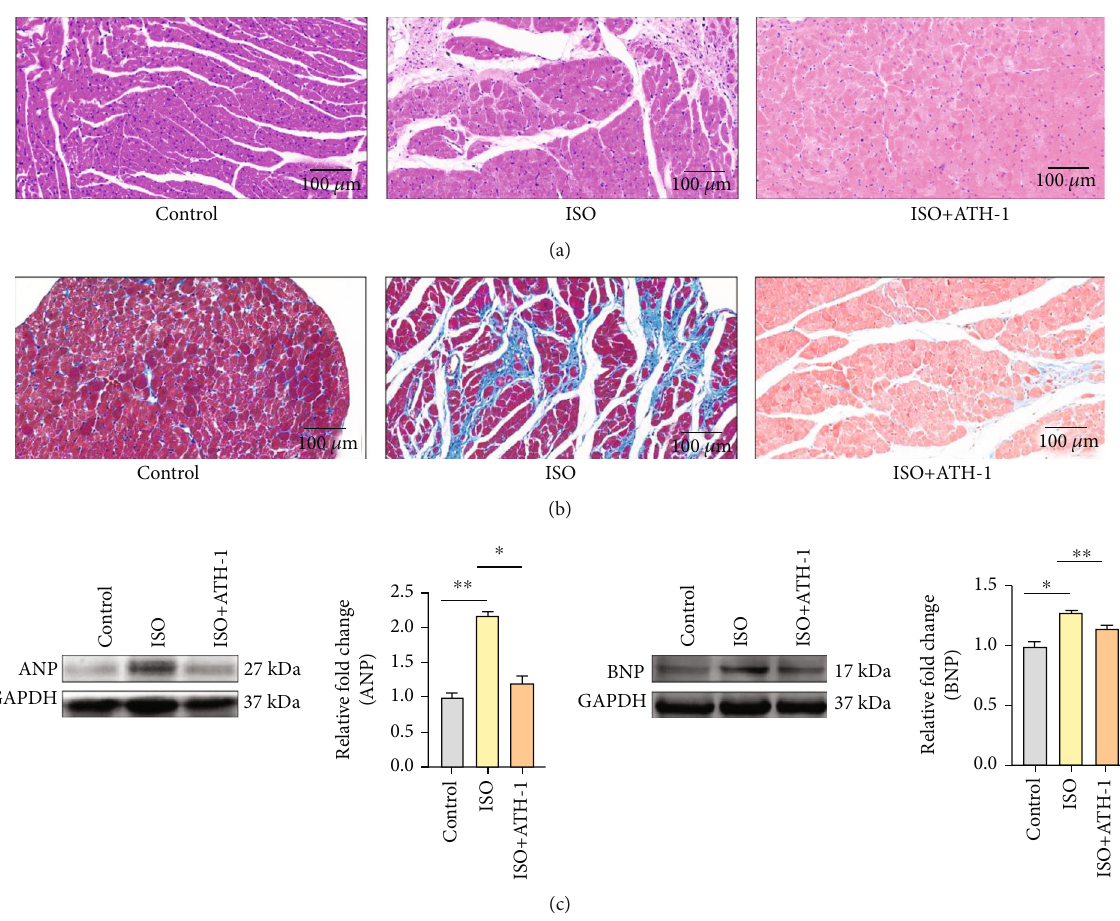
Figure 1: HE staining, Masson staining, and protein expression of ANP and BNP. (a) The cross-section of the cardiac tissue (the magni fi cation is 20.0x) by HE staining in each group ( n = 3 ). (b) The cross-section of the cardiac tissue (the magni fi cation is 20.0x) by Masson staining in each group ( n = 3 ). (c) The protein expression of ANP and BNP in each group ( n = 3 ). ∗ P < 0 : 05 and ∗∗ P < 0 : 01